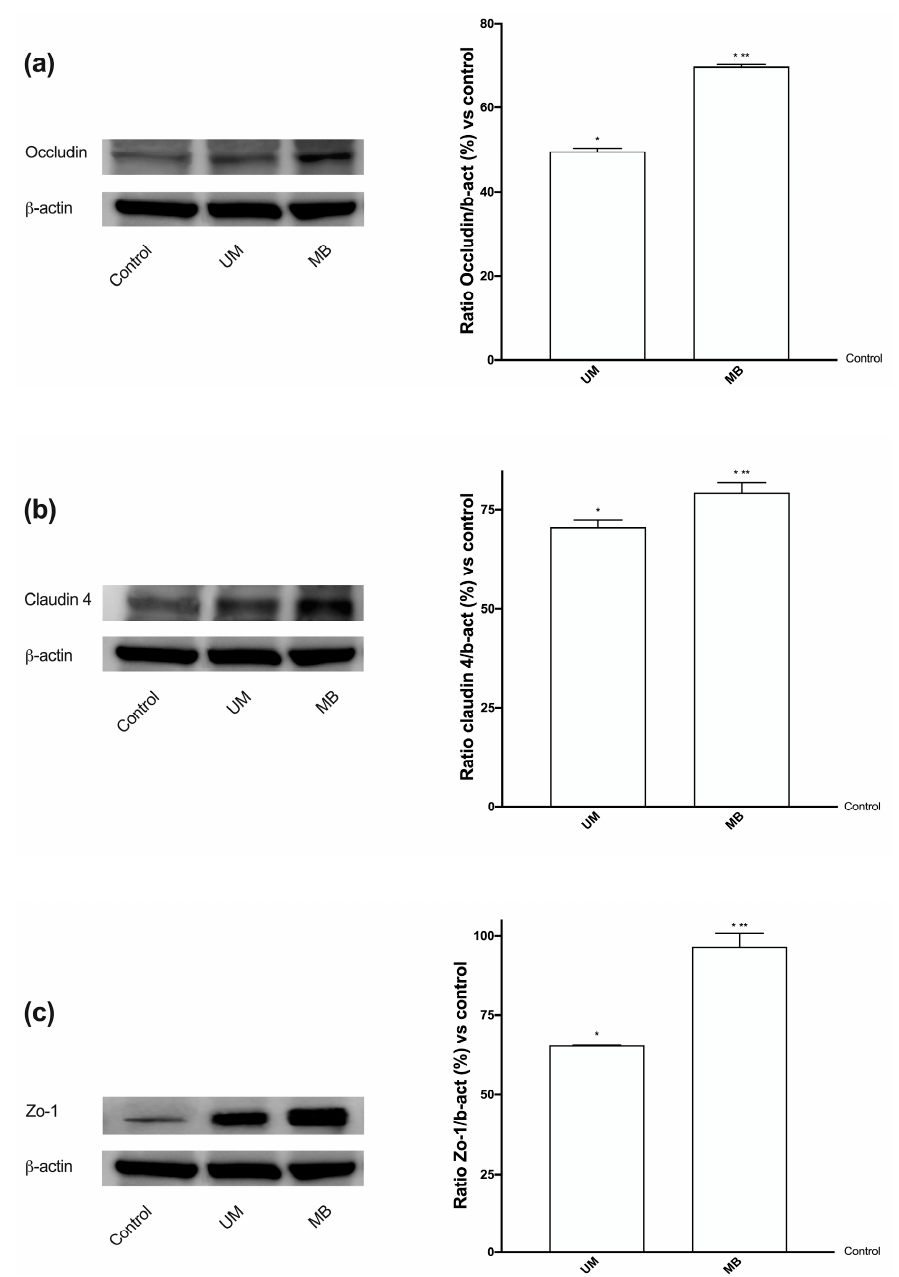
Figure 2. Western blot and densitometric analysis of some tight junctions on Caco-2 cells. Western blot and densitometric analysis of occludin ( a ), claudin 4 ( b ), and Zo-1 ( c ), analyzed on whole Caco-2 lysates at 3 h of stimulations. The images shown are an example of each protein from five independent experiments reproduced in triplicate. Data are expressed as means ± SD (%) of five independent experiments normalized and verified on β -actin detection. The abbreviations are the same as reported in Figure 1. * p < 0.05 vs. control; ** p < 0.05 vs. UM.